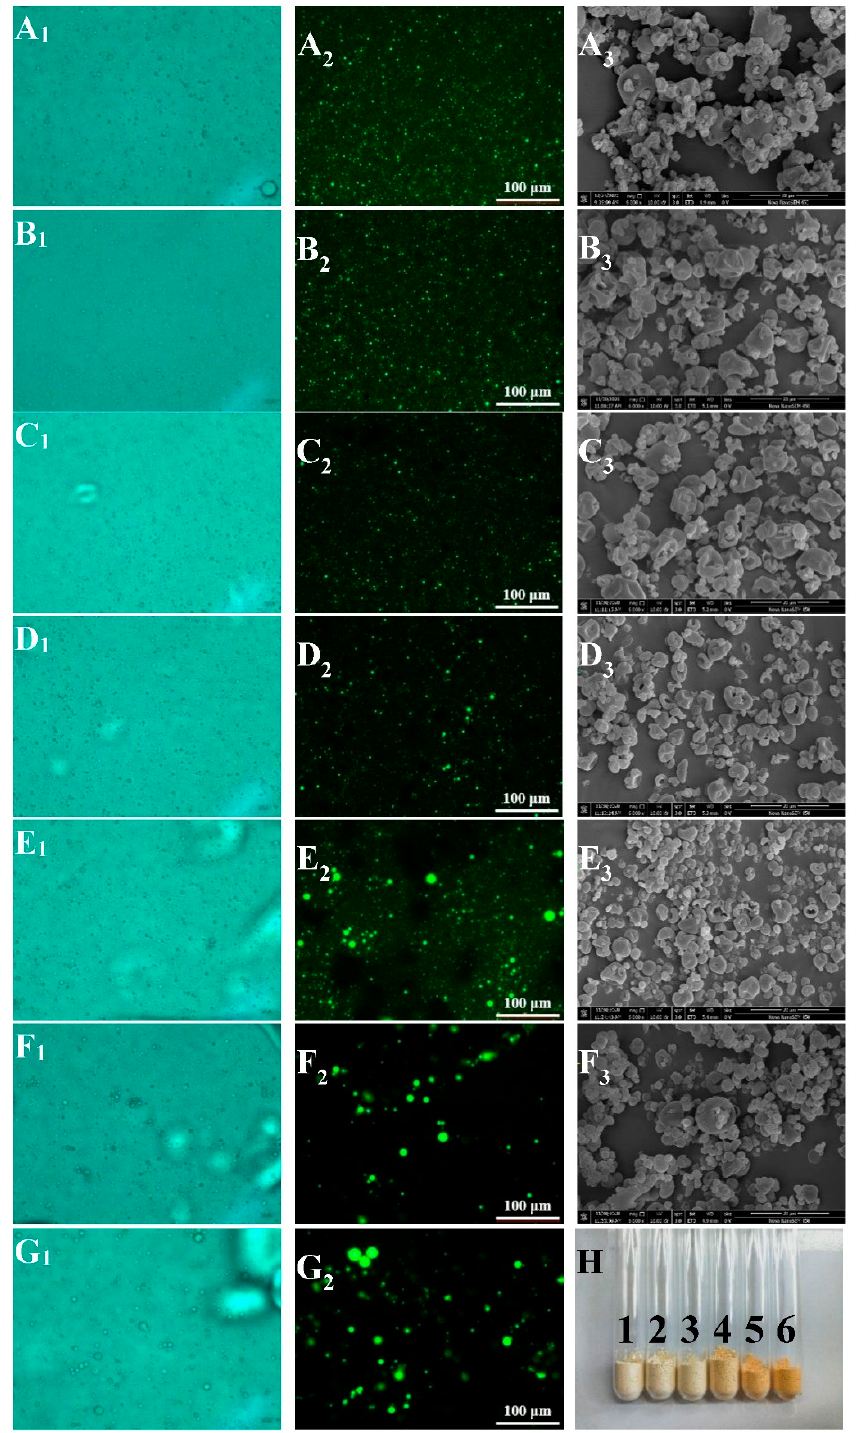
Figure 2. Light micrographs ( × 400) (1) and fluorescence micrographs (AFM) ( × 200) (2) of WP-OS-capsaicin emulsion, scanning electron micrographs (SEM) ( × 6000) (3), and appearance ( H ) of microcapsules. ( A – G ) represent WP (whey protein):OS (OSA-modified starch) at 10:0, 9:1, 7:3, 5:5, 3:7, 1:9, and 0:10, respectively; 1~6 in ( H ) represent WP (whey protein):OS (OSA-modified starch) at 10:0, 9:1, 7:3, 5:5, 3:7, and 1:9,